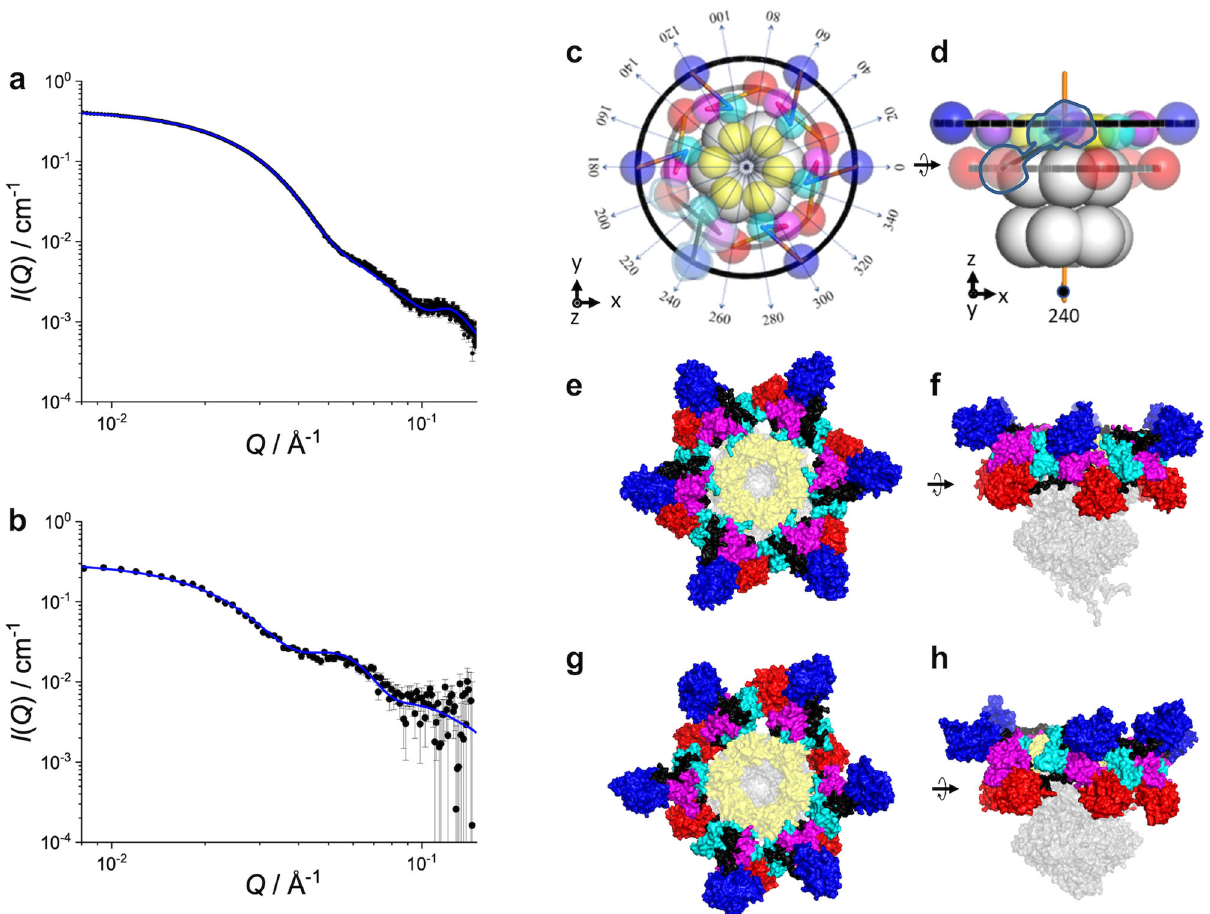
Fig. 5 Best fi t and stable structural model (Model III-2). a SAXS pro fi les. Black circles show the experimental pro fi le and blue line expresses the SAXS pro fi le averaged over the pro fi les calculated from 5000 MD-trajectories of Model III-2. b iCM-SANS pro fi les. Black circles show the experimental pro fi le and blue line expresses the SANS pro fi le averaged over the pro fi les calculated from 5000 MD-trajectories of Model III-2. c Top view and d side view of schematic structure of Model II-2. e Top view and f side view of initial structure, and g top view and h side view of the structure after 100 ns MD simulation. In panels c – h , the color codes for components are same as those in Fig. 3. Error bars in panels a , b represent standard deviation of the